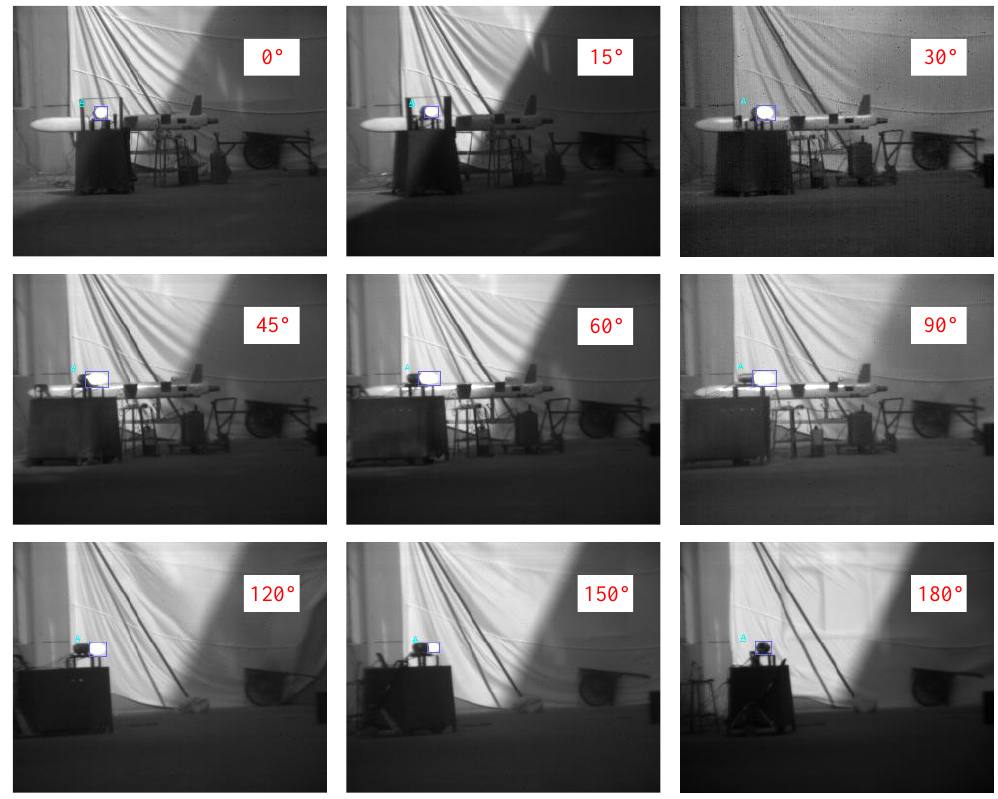
Figure 9. Engine images captured by the short-wavelength infrared (SWIR) camera at different observation angles.